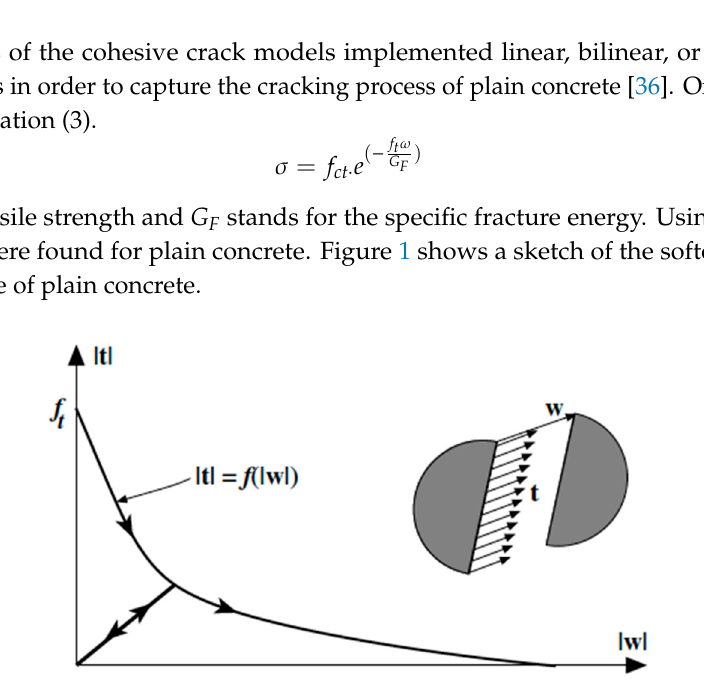
Figure 1. Sketch of the softening curve, with an unloading branch, and the central forces model for the cohesive crack model.